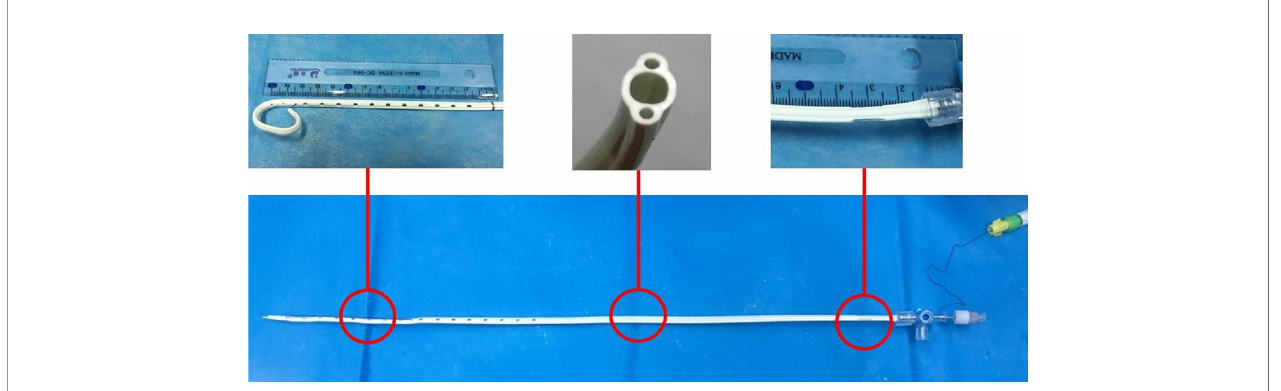
FIGURE 3 | Brachytherapy drainage catheter with three separate cavities: the central cavity has drainage function, and the lateral cavities carry radioactive 125